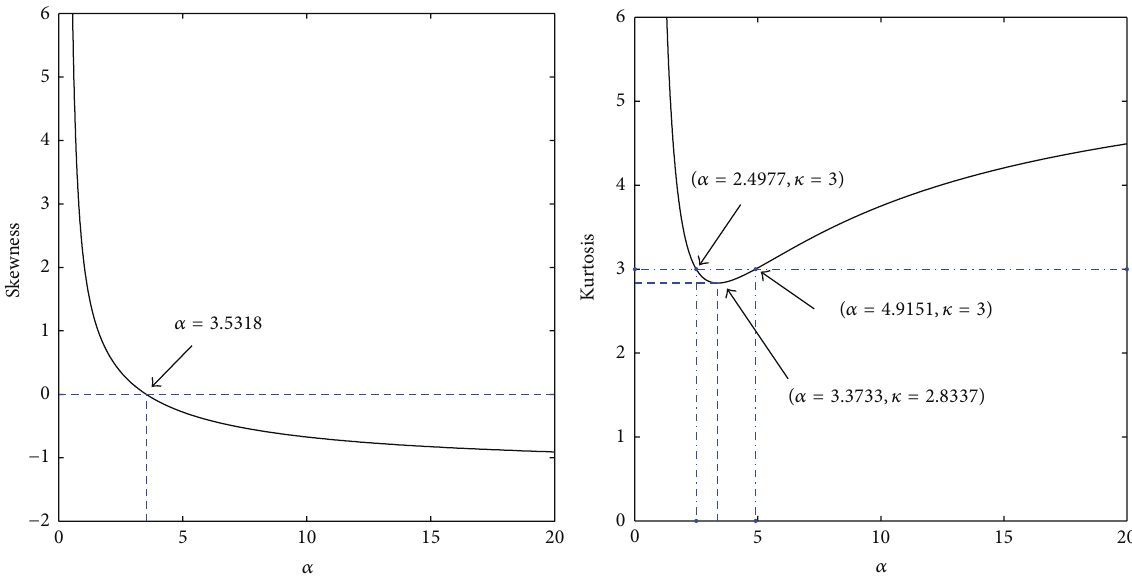
Figure 7: The skewness and kurtosis of TN (𝛼,𝛽) as functions of 𝛼 , when 𝛽 = 1